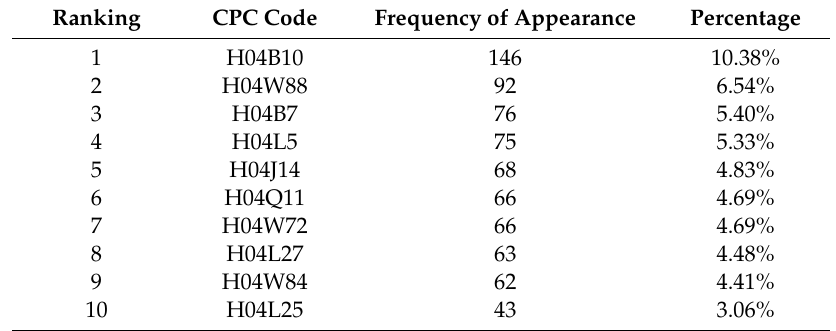
Table 2. Frequency distribution of the top 10 level-4 CPC (Cooperative Patent Classification) codes. Ranking CPC Code Frequency of Appearance